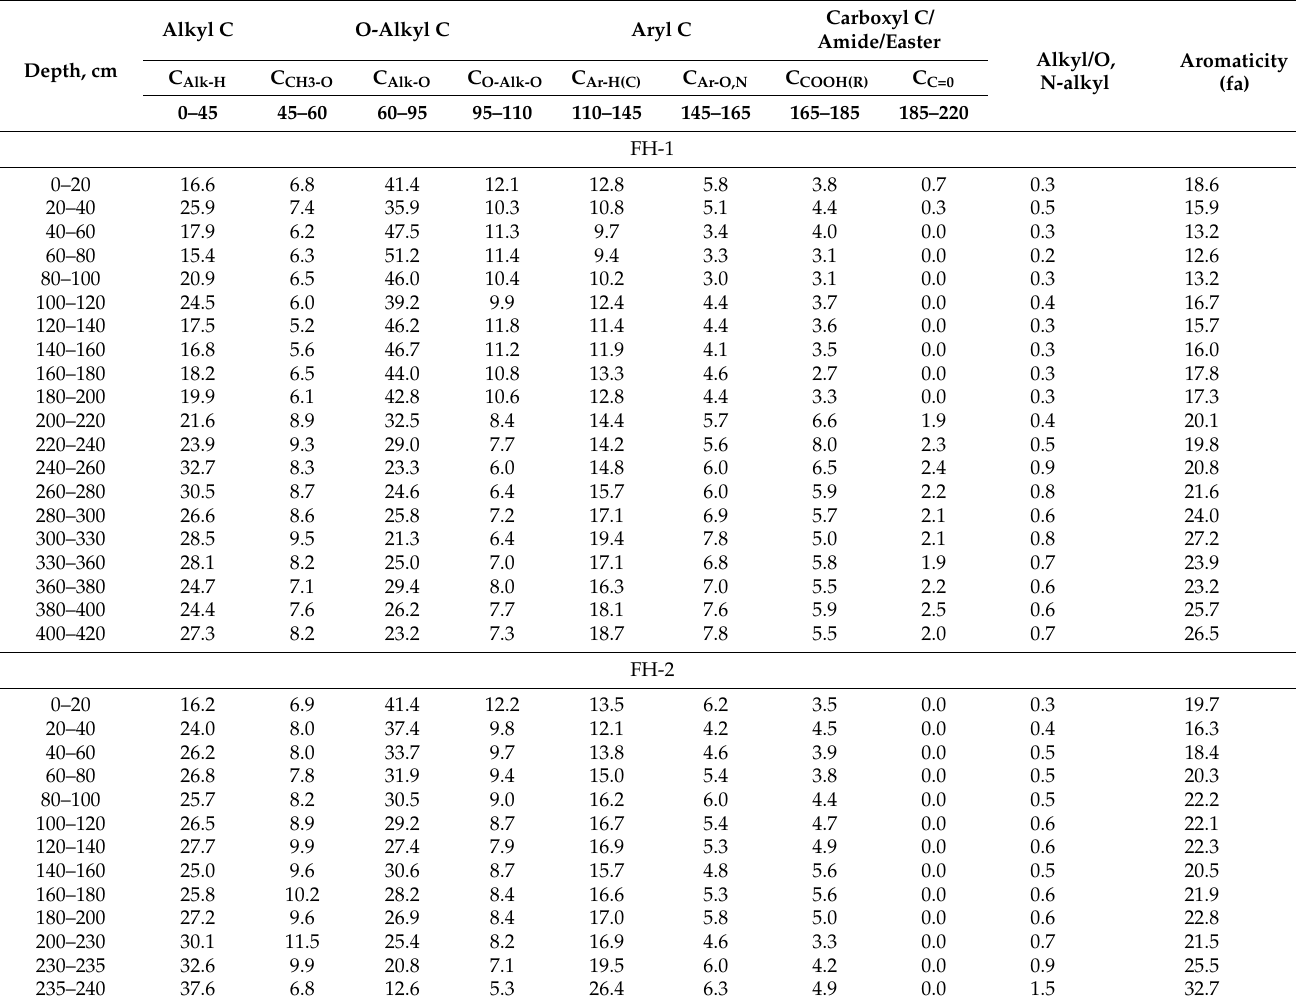
Table 3. Percentage distribution (%) of signal intensity between selected chemical shift regions (ppm) of 13 CPMAS NMR spectra of bulk